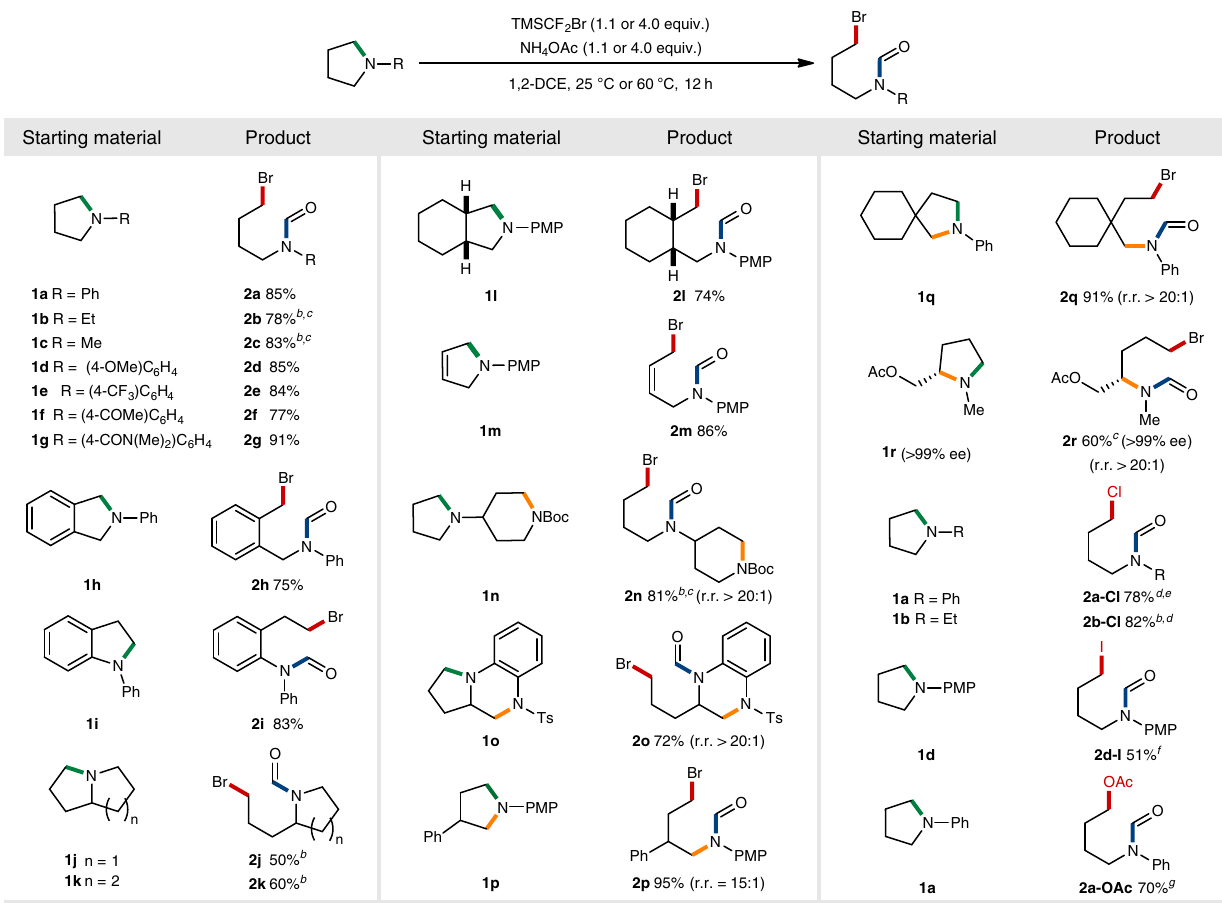
Fig. 3 Reaction scope of fi ve-membered cyclic amines. a Reaction conditions: Unless otherwise indicated, all reactions were performed on a 0.2 mmol scale using cyclic amine (1.0 equiv.), TMSCF 2 Br (4.0 equiv.), NH 4 OAc (4.0 equiv.) and 1,2-DCE (0.5 mL) at room temperature. regioselectivity ratios (r.r.) were determined by 1 H NMR spectroscopy of crude mixtures. b 60 °C. c 1.1 equiv. of TMSCF 2 Br and 1.1 equiv. of NH 4 OAc. d TMSCF 2 Cl (4.0 equiv.) instead of TMSCF 2 Br. e KF (4.0 equiv.) as an alternative base, with H 2 O (0.05 mL) as a co-solvent. f TMSCF 2 I (4.0 equiv.) instead of TMSCF 2 Br. g 4.0 equiv.